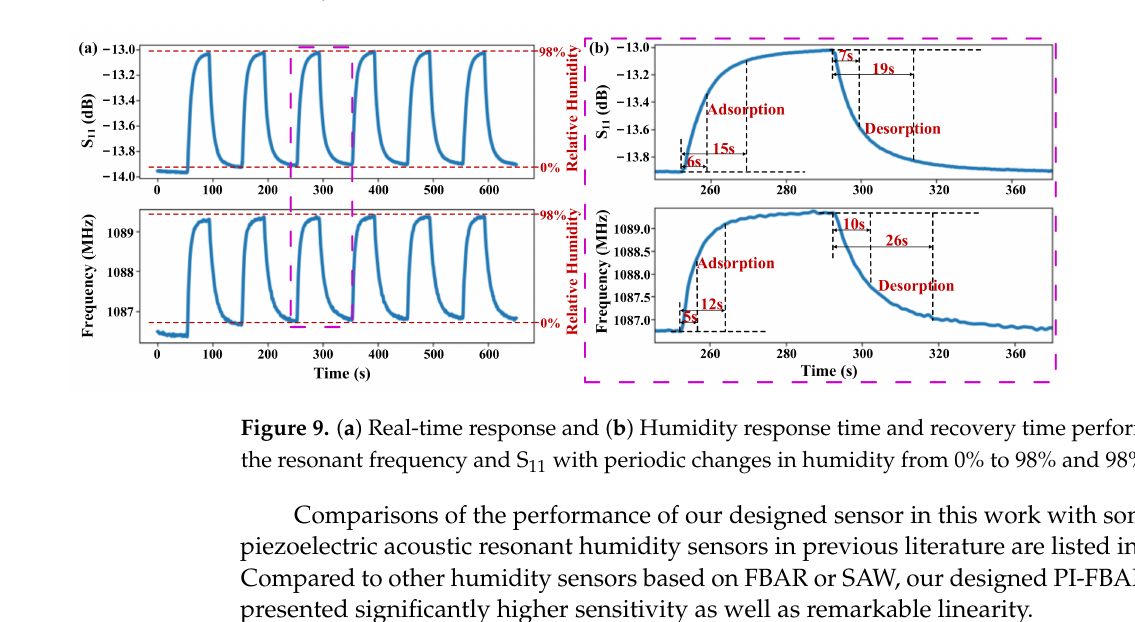
Figure 8. Stability analysis of the sensor for 6 h ( a ) for resonant frequency and ( b ) for S 11 in different humidity environments.